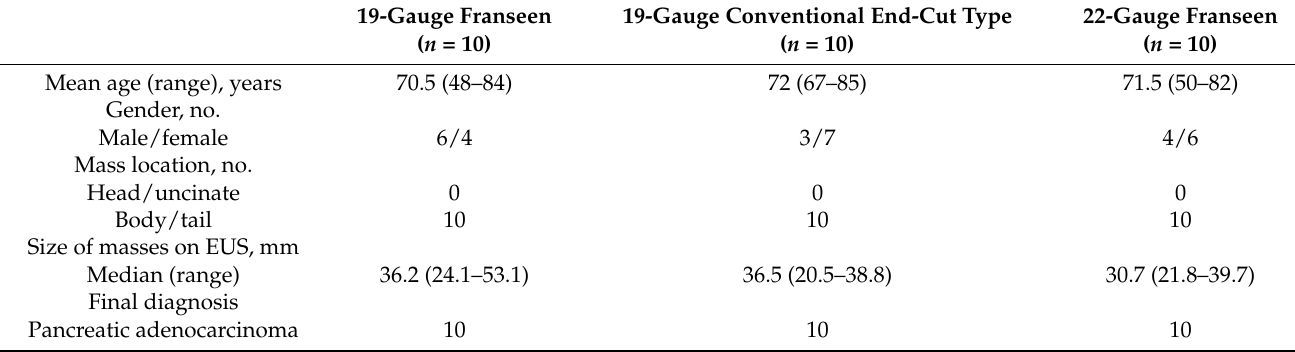
Table 1. Baseline characteristics and pancreatic solid lesions details.